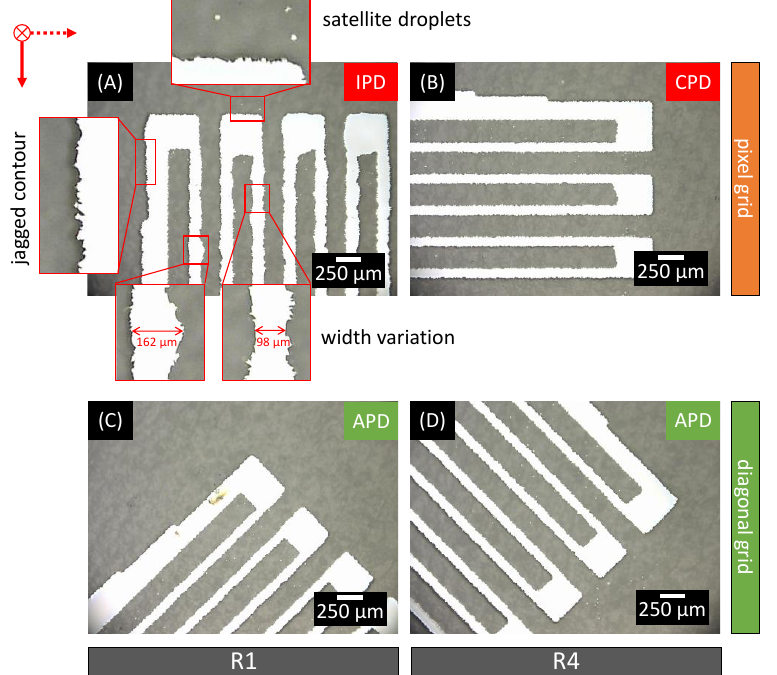
Figure 10. Microscopic images of SG full bridges on PEN substrate. Comparison of IPD ( A ) and CPD ( B ) printed conductors on a conventional pixel grid and APD; ( C , D ) printed conductors on a diagonal grid.